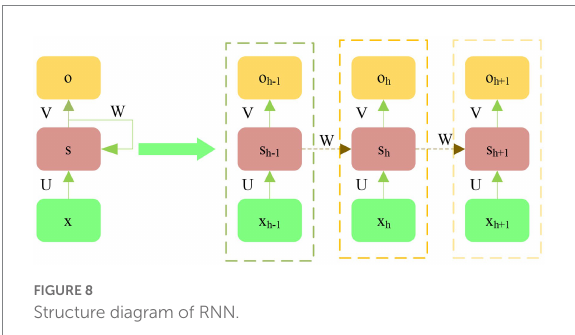
FIGURE 8 Structure diagram of